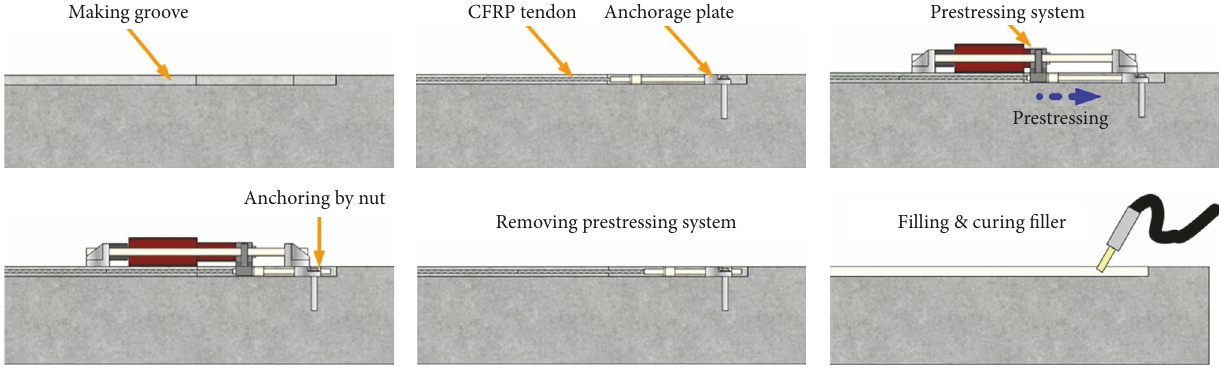
Figure 5: Application of the new prestressing